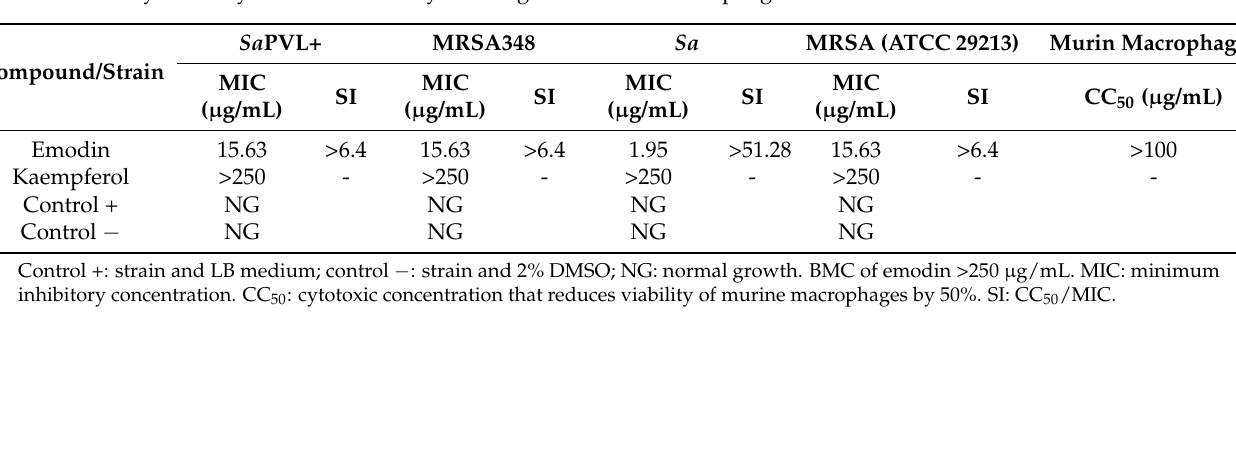
Table 4. Minimum inhibitory concentrations of pure compounds isolated from R. alaternus fractions against the four strains of S. aureus cytotoxicity test and selectivity index against murine macrophages. Sa PVL+ Compound/ Strain